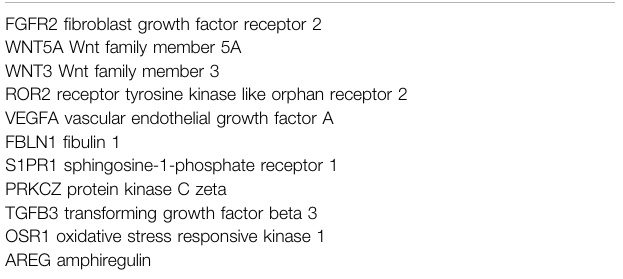
TABLE 2 | Main downregulated genes contributing to enriched GO terms, in the 1 nm T3 group.